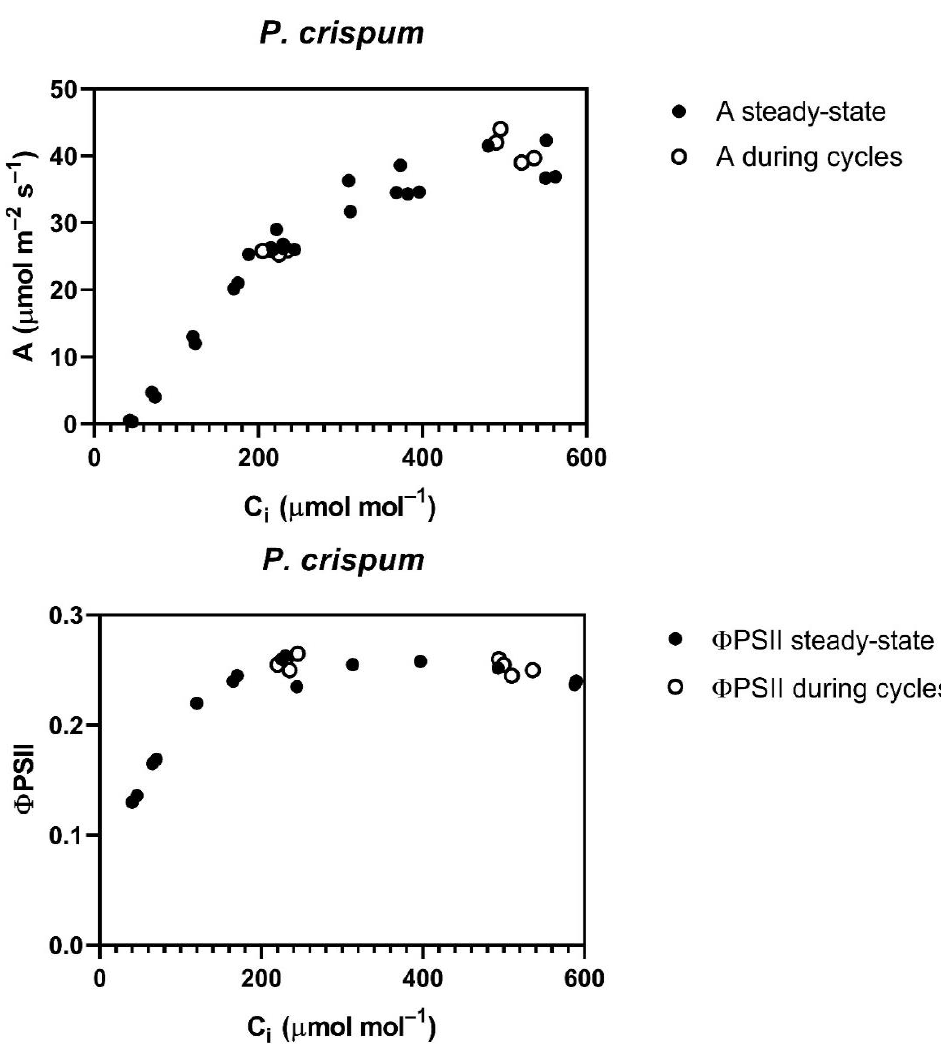
The P. crispum , in contrast to the other four species, had no reduction in the A vs. curve, or in ΦPSII after the cycling of CO 2 (Figure 2), and also showed no change in sto- C i curve, or in Φ PSII after the cycling of CO 2 (Figure 2), and also showed no change in matal conductance with CO 2 (Table 1). stomatal conductance with CO 2 (Table 1).